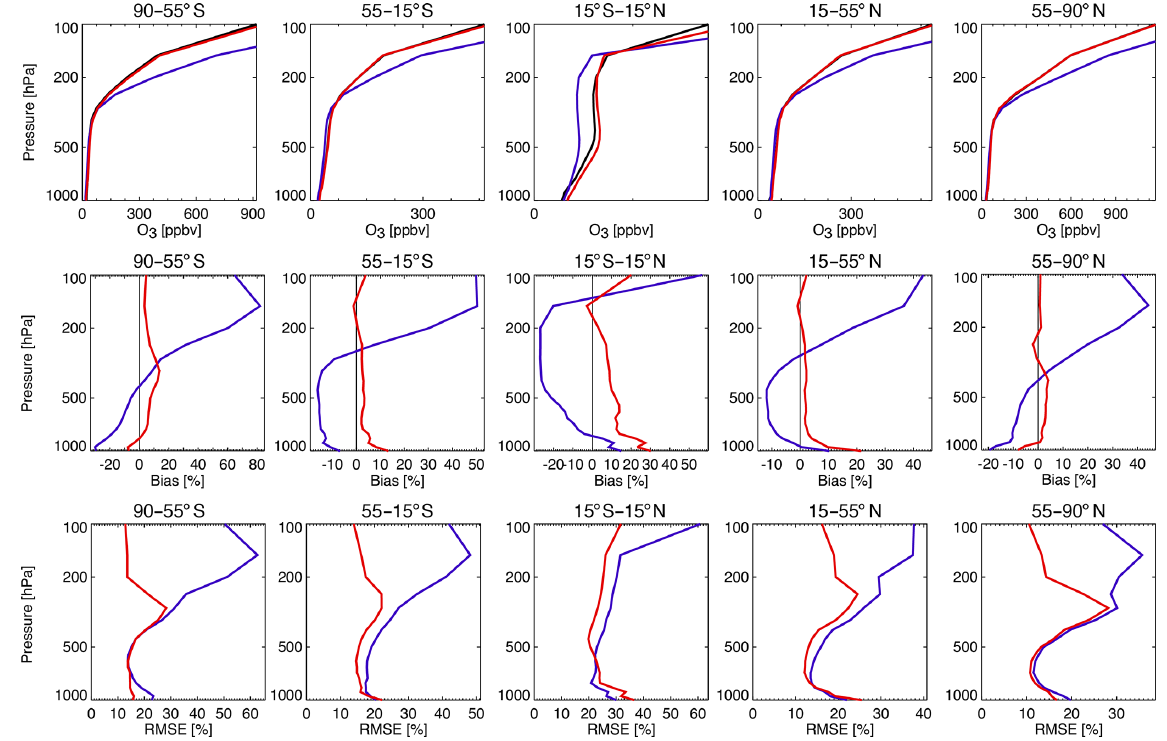
Figure 1. Comparison of the vertical ozone profiles between ozonesondes (black), control run (blue), and reanalysis (red) averaged for the period 2005–2018. The upper row shows the mean profile; center and lower rows show the mean difference and the root-mean-square error (RMSE) between the control run and the observations (blue) and between the reanalysis and the observations (red). From left to right, results are shown for the Southern Hemisphere (SH) high latitudes (55–90 ◦ S), SH midlatitudes (15–55 ◦ S), the tropics (15 ◦ S–15 ◦ N), Northern